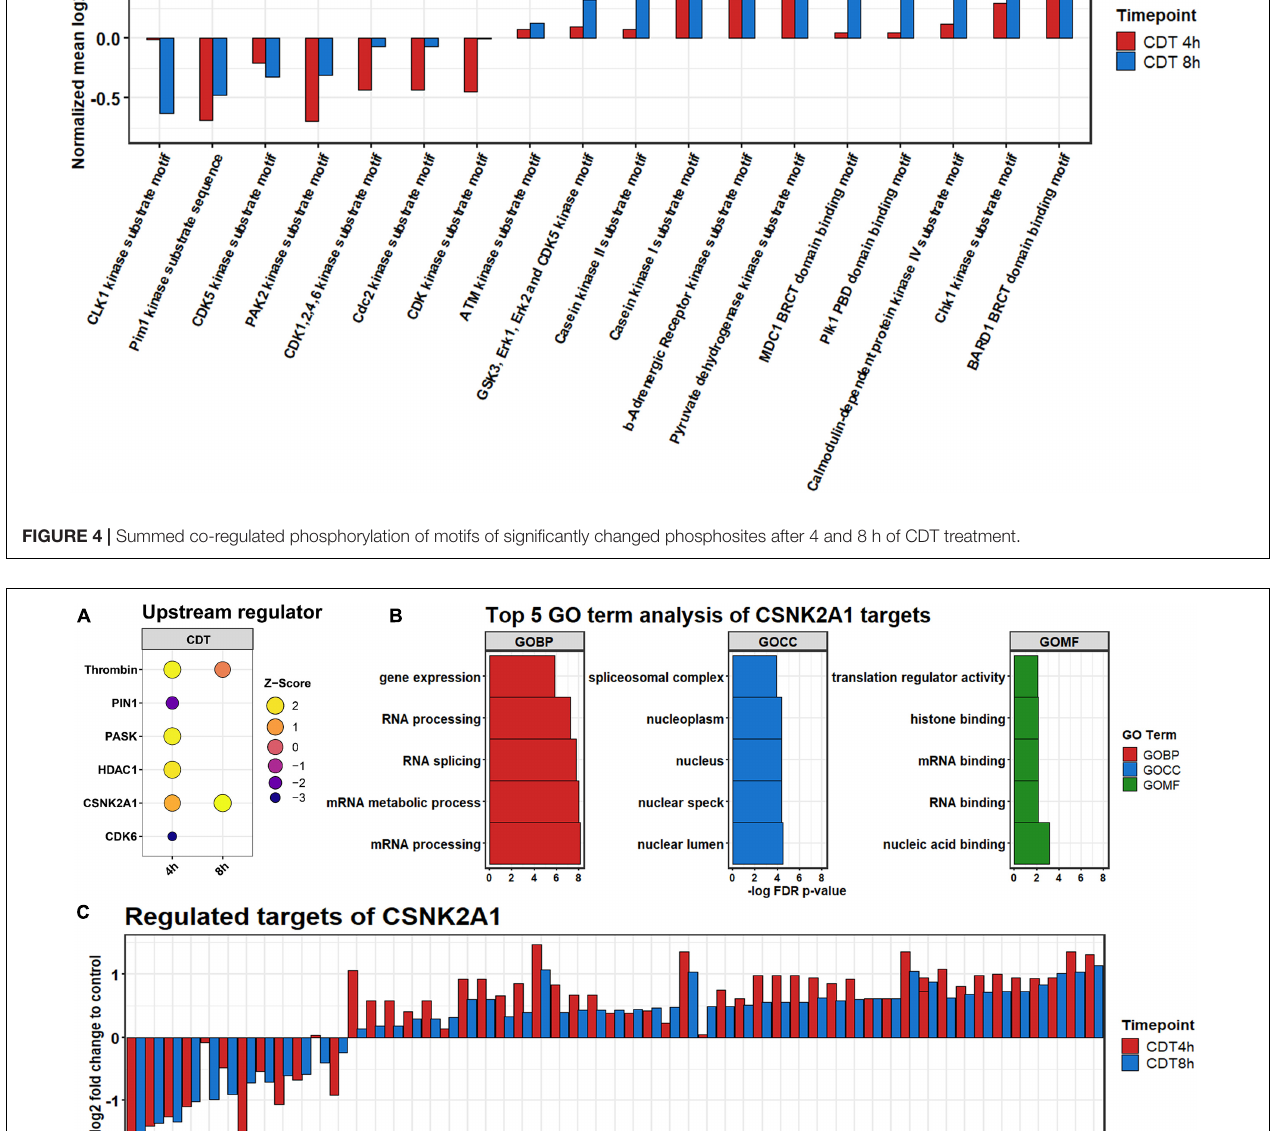
(Jensen et al., 2009). Highly enriched were GO-terms that were part of the translational process like “RNA splicing” and “translational regulator activity.” The 30 most enriched GO terms for each time point are depicted in Supplementary Figures 3, 4 .